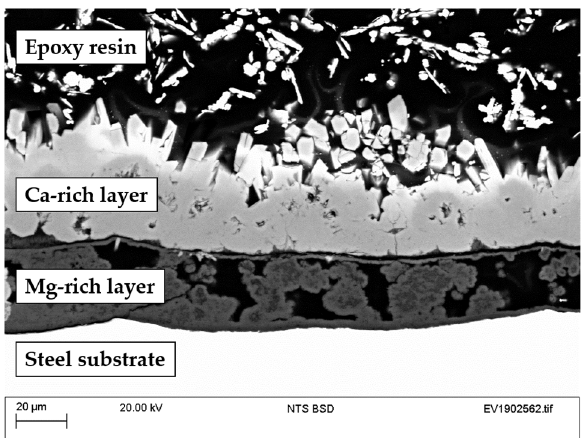
Figure 8. SEM (scanning electron microscopy) cross-sectional image of defect area of a TS sample exposed for 50 days to artificial seawater under controlled laboratory conditions.